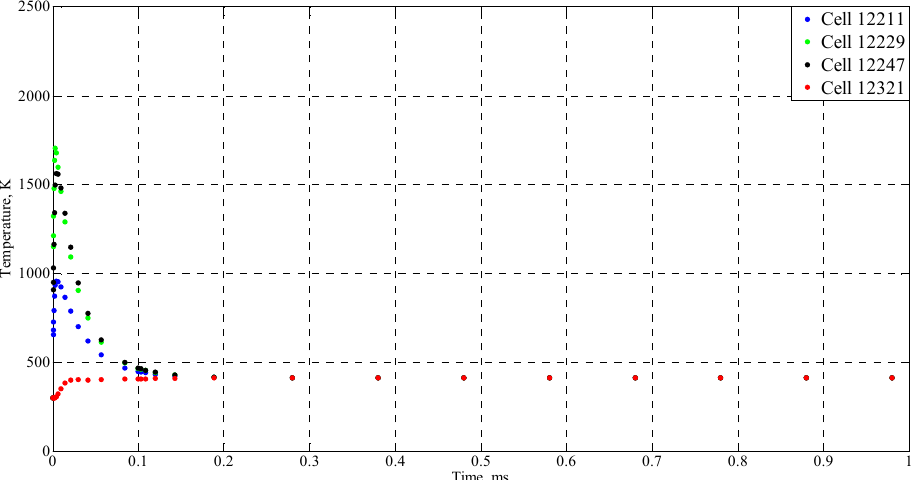
Figure 13. Temperature evolution in the steel cells 12211, 12229, 12247 and 12321.